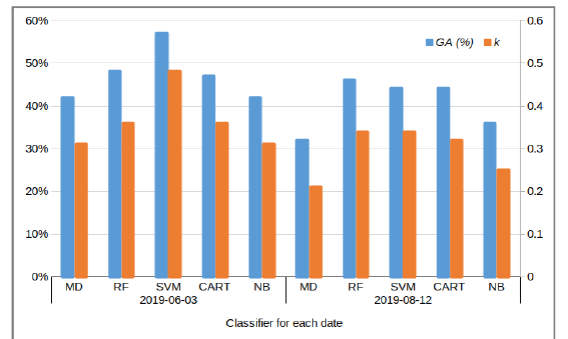
Figure 3. Comparison of GA and k for each classifier and date used in Scenario 1